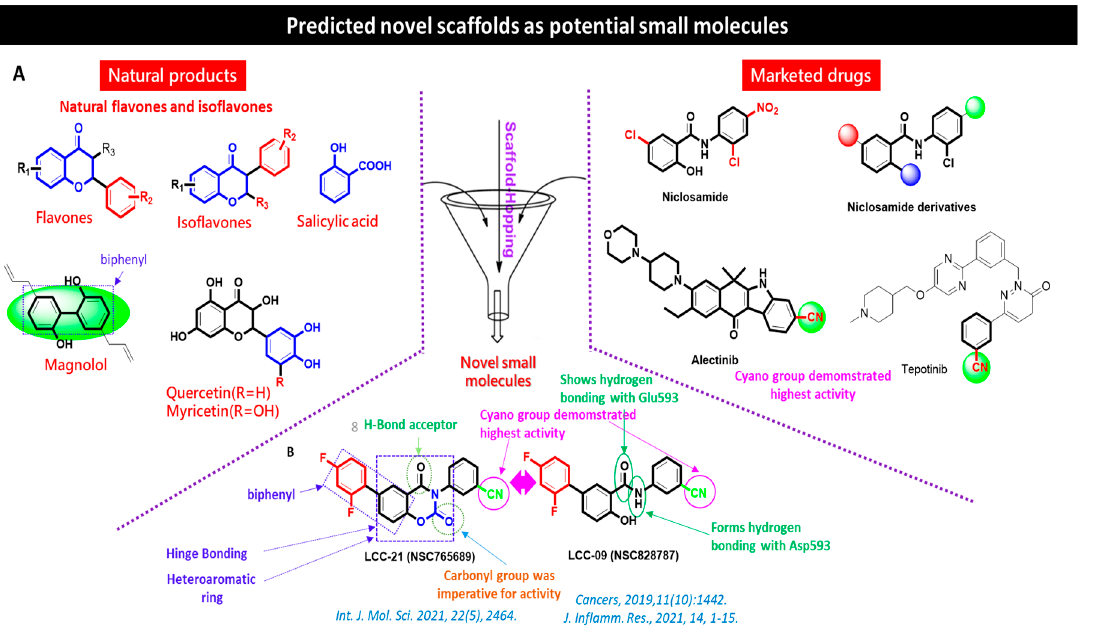
Figure 2. Chemical synthesis of the Novel Multi ‐ Target small molecules NSC828787 (LCC09) and NSC765689 (LCC ‐ 21): ( A ) several novel series of 5 ‐ (2 ′ ,4, ‐ difluorophenyl) ‐ niclosamide derivatives based on difluorobiphenyl and niclosamide scaffolds, and ( B ) novel small molecule LCC ‐ 21 and LCC ‐ 09 consisting of magnolol, 2,4 ‐ difluorophenyl, and niclosamide functional fragments.